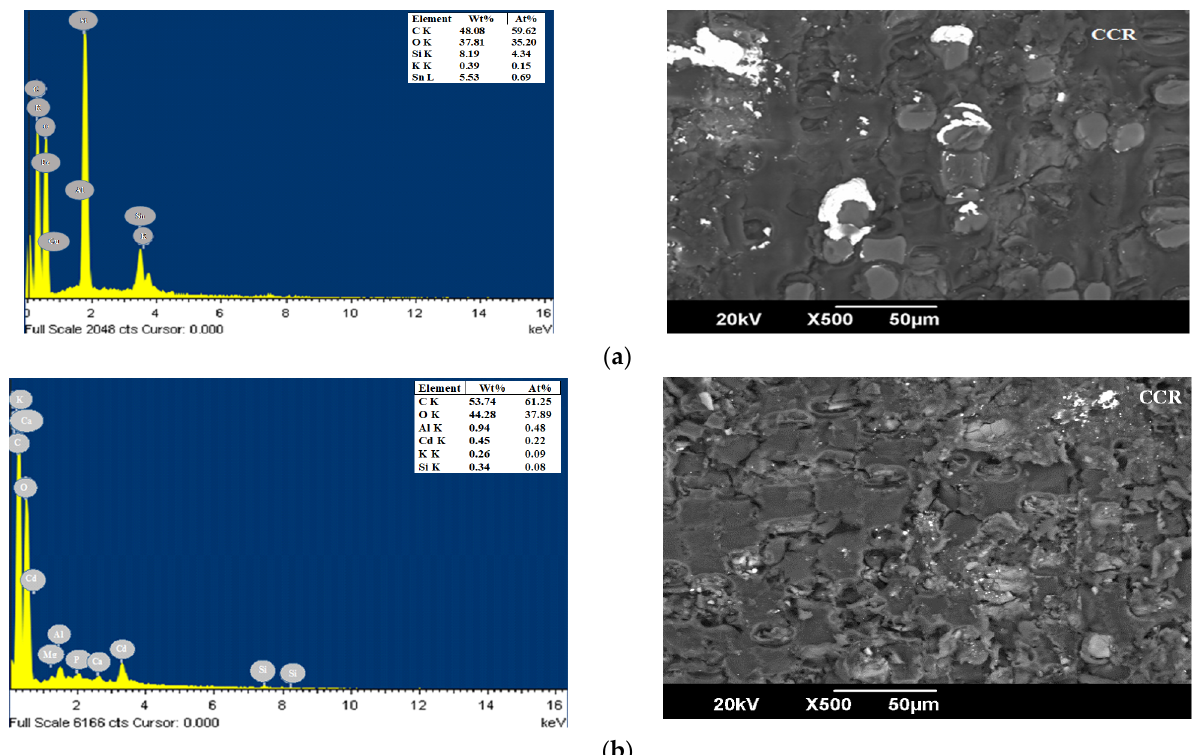
Figure 5. EDS spectra and -SEM micrographies for CCR: ( a ) before and ( b ) after adsorption.